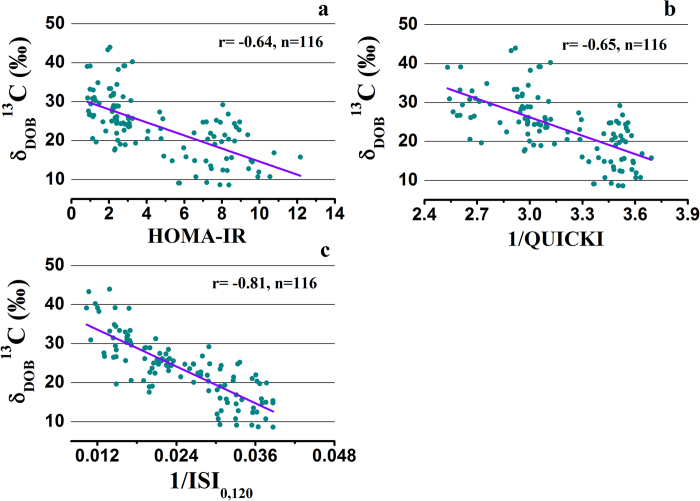
Correlations of δDOB13C(‰) in breath with currently available insulin resistance assessment methods.a, HOMA-IR. b, 1/QUICKI. c, 1/ISI0,120. The data are statistically significant different (p < 0.01).